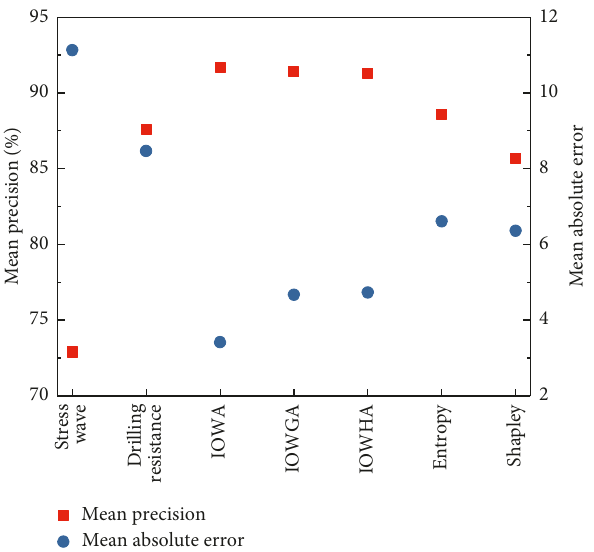
Figure 10: Curves of mean precision and mean absolute